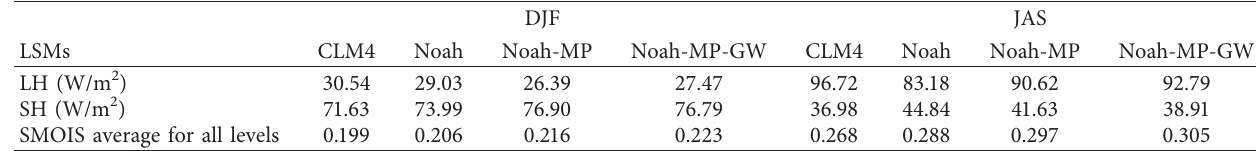
Figure 19: Spatial distribution of surface sensible heat (w/m 2 ) for Dec 16 th , 2011–Feb 28 th , 2012. (a) Naoh. (b) CLM4. (c) NaohMP. (d) NoahMP GW. Table 5: Average values of SH, LH, and soil moisture (SMOIS) over 10 ° W–10 ° E and 5 ° –15 °